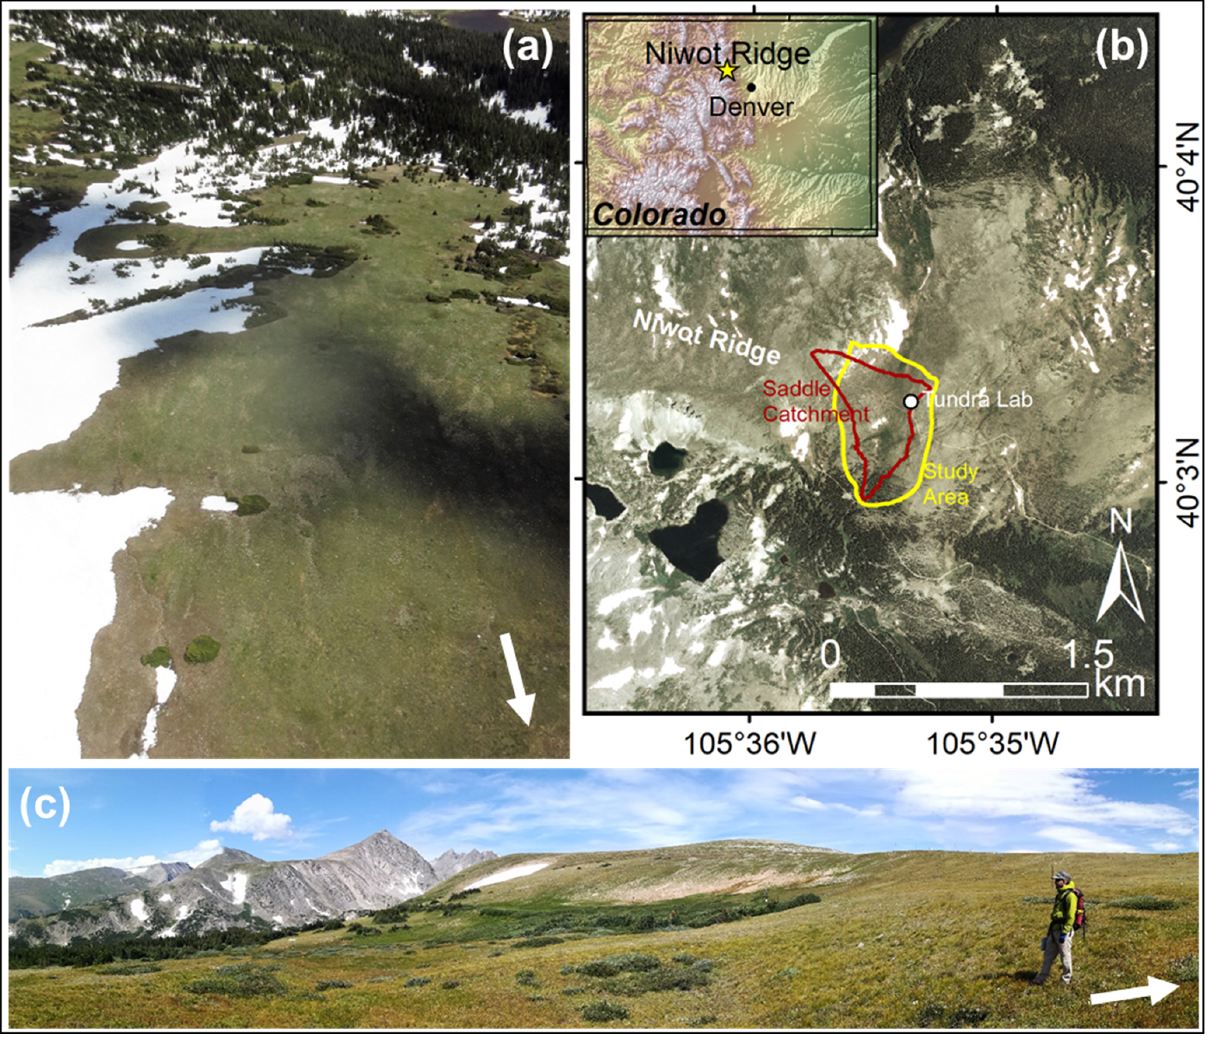
Figure 1. Study site at Niwot Ridge (white arrows on photos indicate north). (a) Oblique aerial image of the study site looking downslope (south) from the northern edge, (b) study site location and relevant boundaries, and (c) terrestrial view of the study site from the eastern edge of the study site looking west. Base imagery in panel (b) sourced from the public-access USA National Agricultural Imagery Program (NAIP)